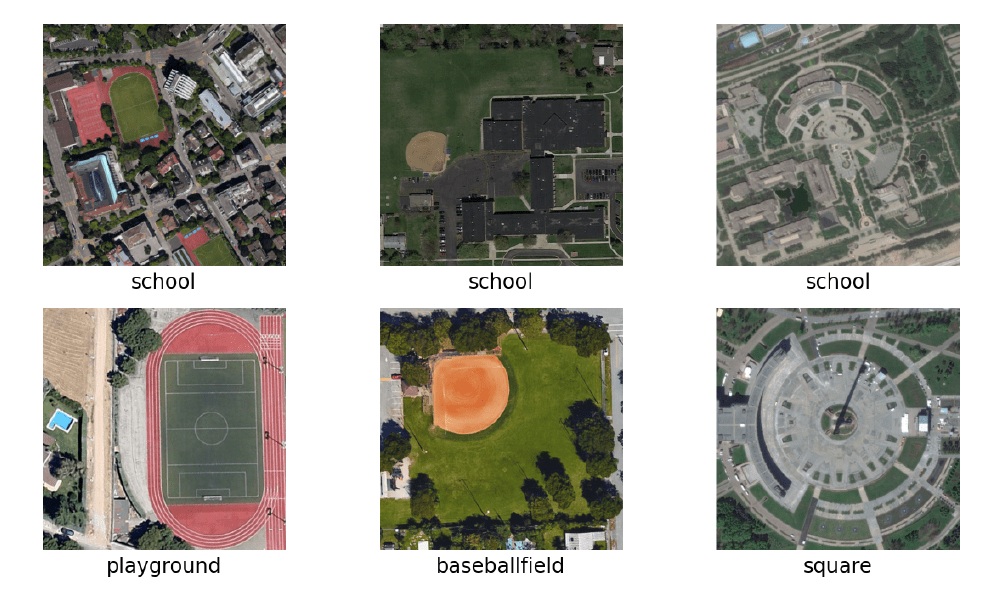
Figure 1. Several sample images from the AID datasets